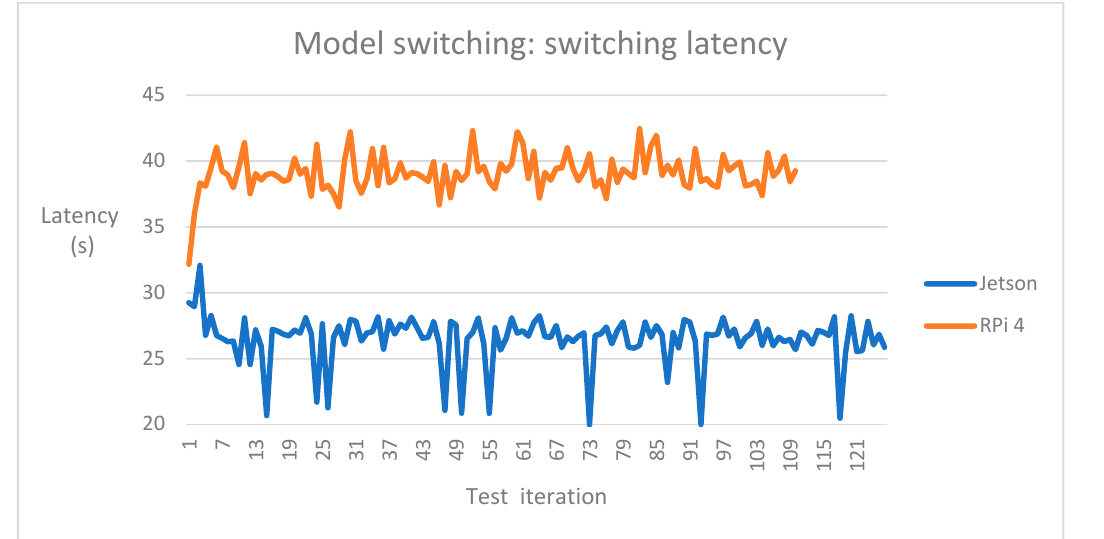
Figure 9. Results of prediction tests with model switching.